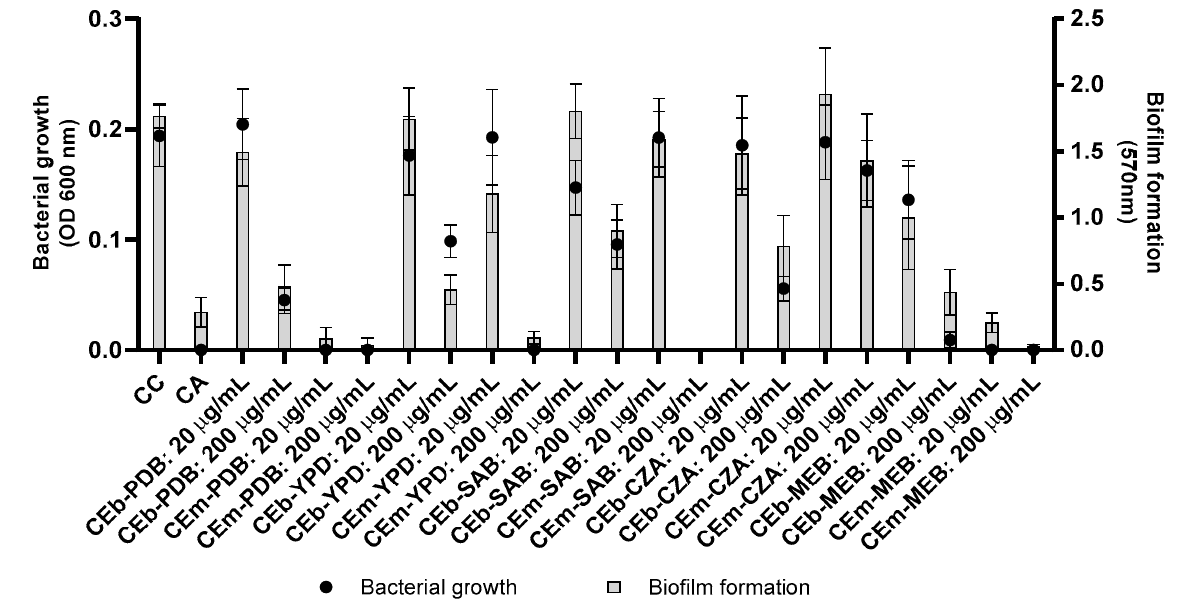
Figure 2. Biofilm formation and bacterial growth of S. aureus treated with the crude extracts of my- celial biomass (CEm—CEm-PDB, CEm-YPD, CEm-SAB, CEm-CZA, and CEm-MEB) and broth (CEb—CEb-PDB, CEb-YPD, CEb-SAB, CEb-CZA, and CEb-MEB) of Penicillium sp. strain 5MP2F4 at concentration 20 and 200 µg/mL. CC = growth control, culture medium only; CA = activity control, gentamicin 20